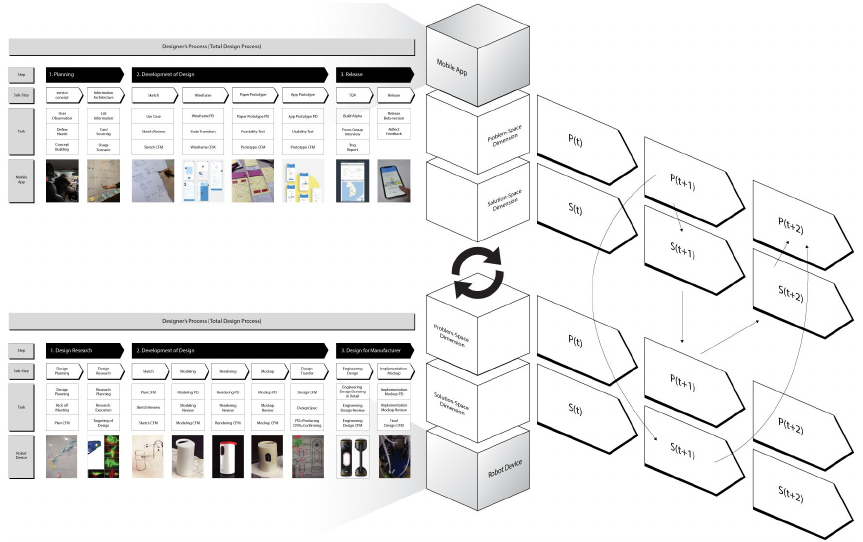
Figure 3. The total design process and thumbnails of sensor robot used in the highways/roads and the converged mobile app to get information from the robots in network. Each process includes planning - data collection - idea sketching - prototype stages, and the prototype that repeats modifications.